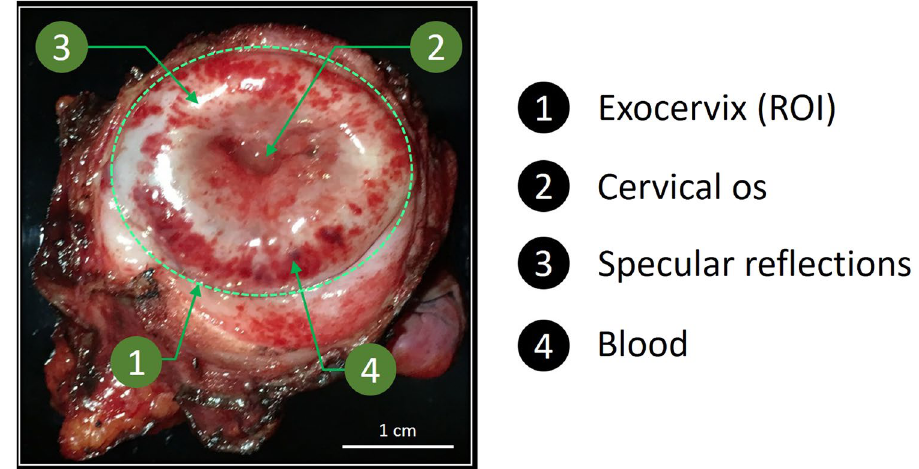
Figure 2. Unpolarized RGB picture of the uterine cervix from a complete hysterectomy from a patient with normal Pap